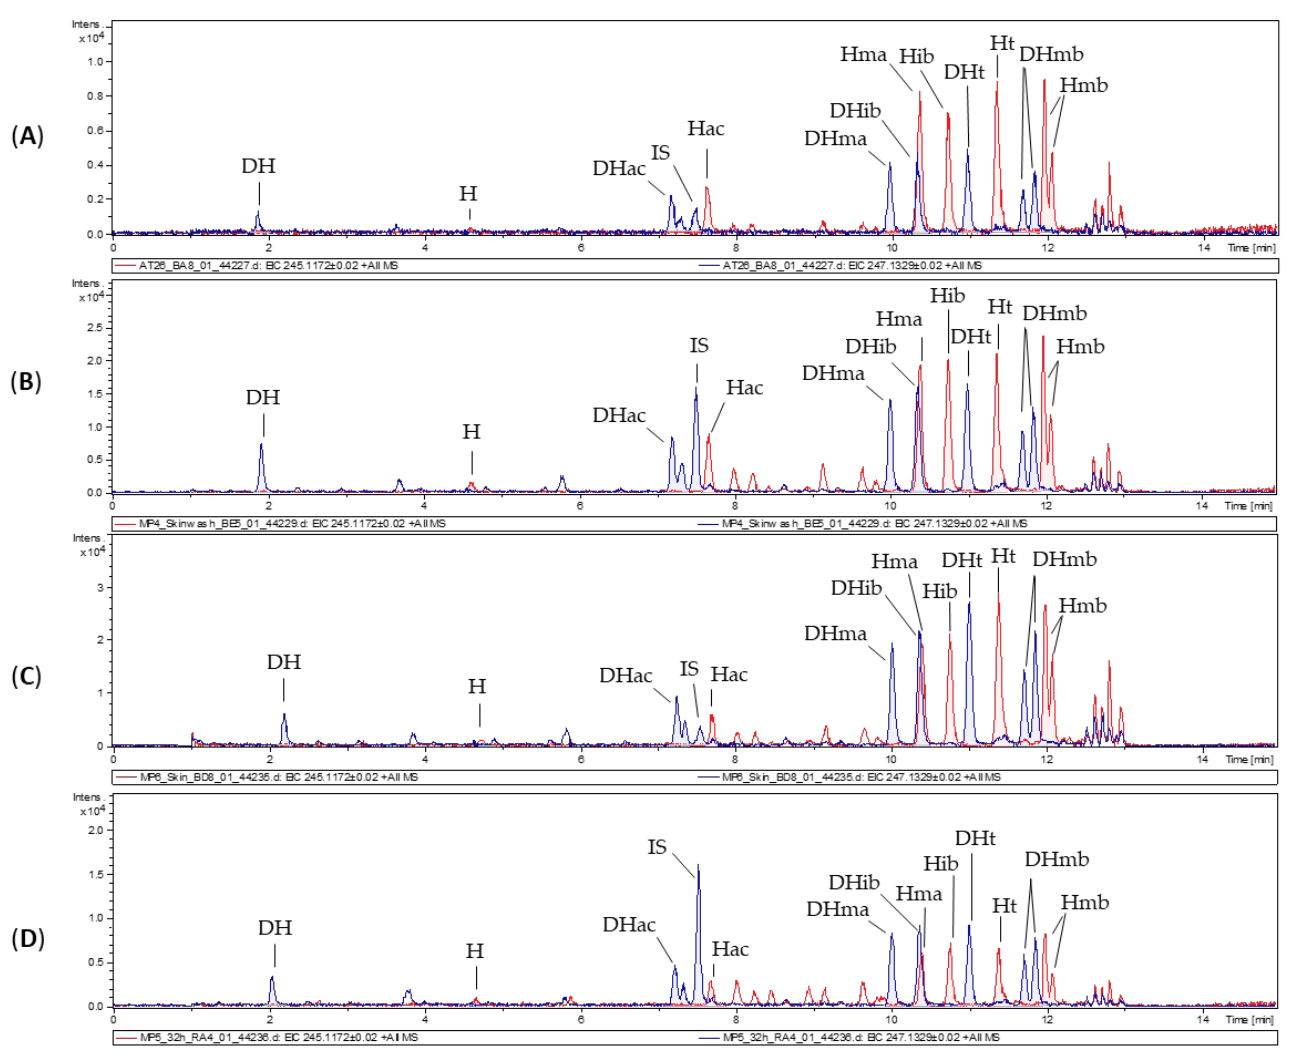
Figure 1. UHPLC-HRMS chromatograms with EICs of m / z 245.1172 (red, Hs) and m / z 247.1329 (blue, DHs) of the applied Arnica tincture ( A ) and representative samples of a receptor fluid ( B ), a skin extract ( C ) and a skin wash solution ( D ).